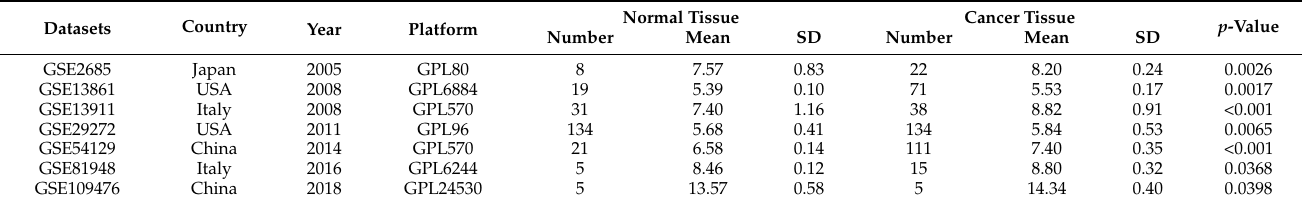
Table 1. HSF1 expression profile in GEO